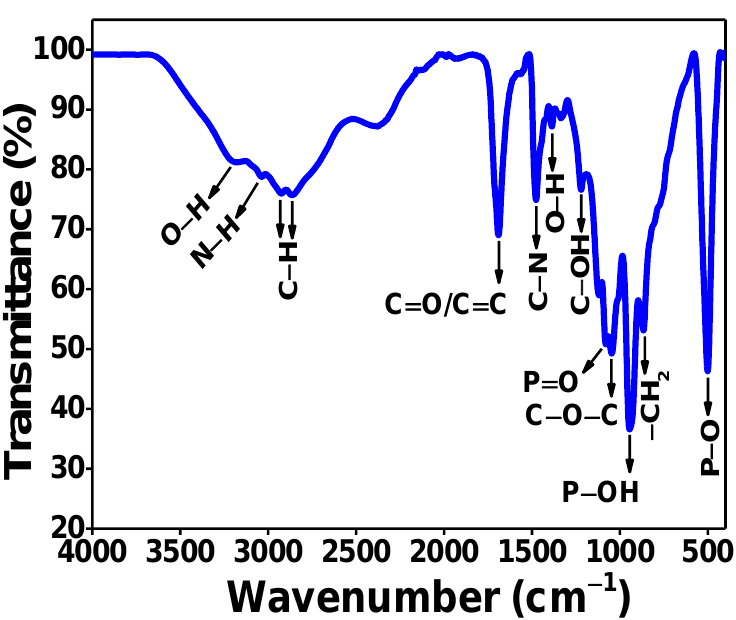
Figure 3. ATR-FTIR spectrum of P-CDs synthesized from PMPC.